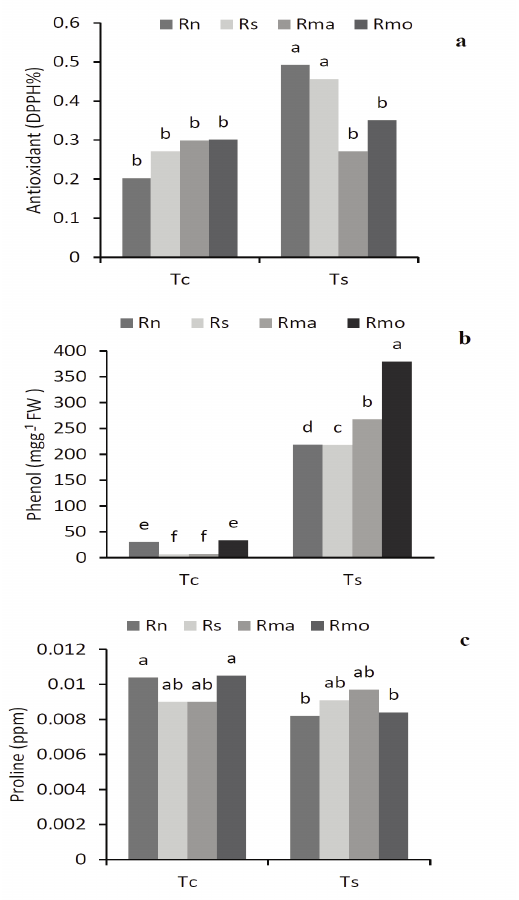
Fig. 10 ­ The interaction effect of temperature and cucumber grafting on antioxidant (a) and phenol (b) and proline (c) Tc= optimum temperature; Ts= low temperature; Rn = nongrafted ( Cucumis sativus var. DavosII); Rs= self grafted; Rma= Cucurbita maxima ; Rmo= Momordica charantia